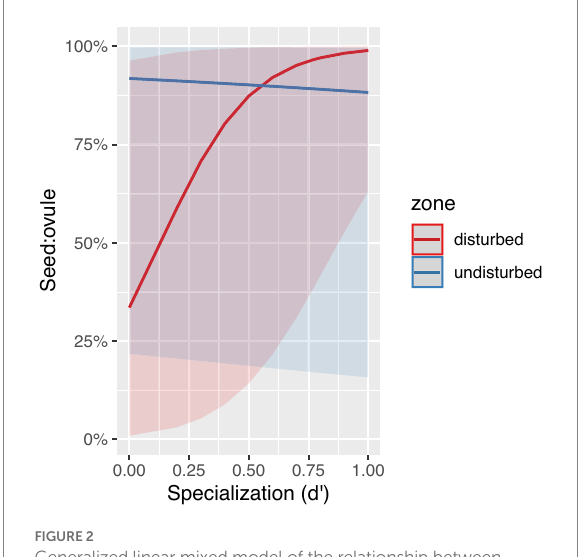
FIGURE 2 Generalized linear mixed model of the relationship between seeds per ovule and the specialization index (d’) for species found within quadrats in the disturbed and undisturbed zones.